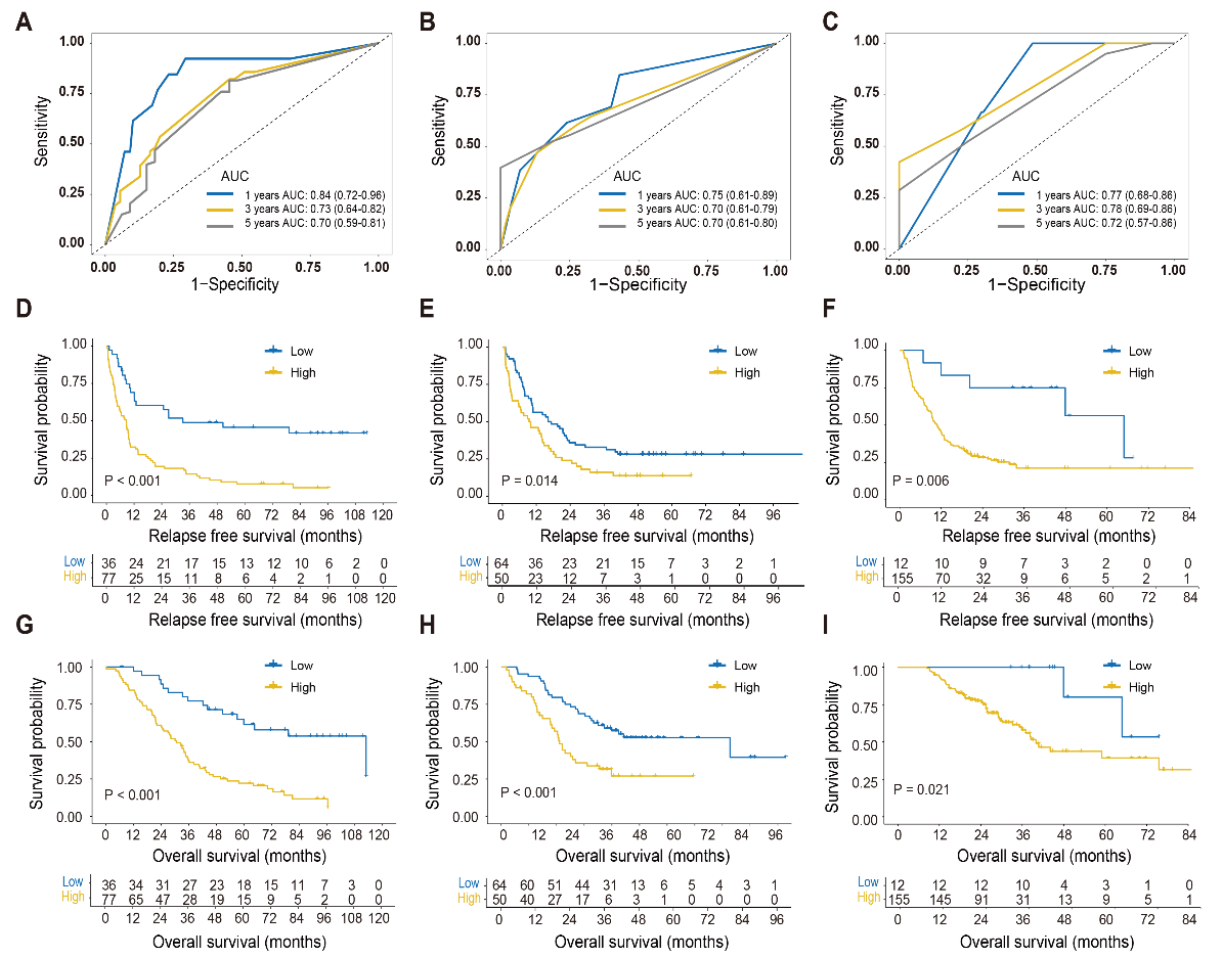
Figure 3. Time-dependent receiver operating characteristic (ROC) curves and Kaplan–Meier curves of relapse-free survival and overall survival for the circulating exosomal miRNA model. ( A – C ) Time-dependent ROC curves based on the circulating exosomal miRNA score in the training ( A ), internal validation ( B ), and external validation cohort ( C ). The prognostic accuracy of the model was assessed by the 1-, 3-, and 5-year AUCs of overall survival. The 95% CI was estimated by the bootstrap method. ( D – I ) Kaplan–Meier curves for relapse-free survival and overall survival in different exosomal miRNA risk CRLM groups in the training ( D , G ), internal validation ( E , H ), and external validation cohorts ( F , I ). CRLM, colorectal cancer liver metastases; AUC, area under the curve; CI, confidence interval.